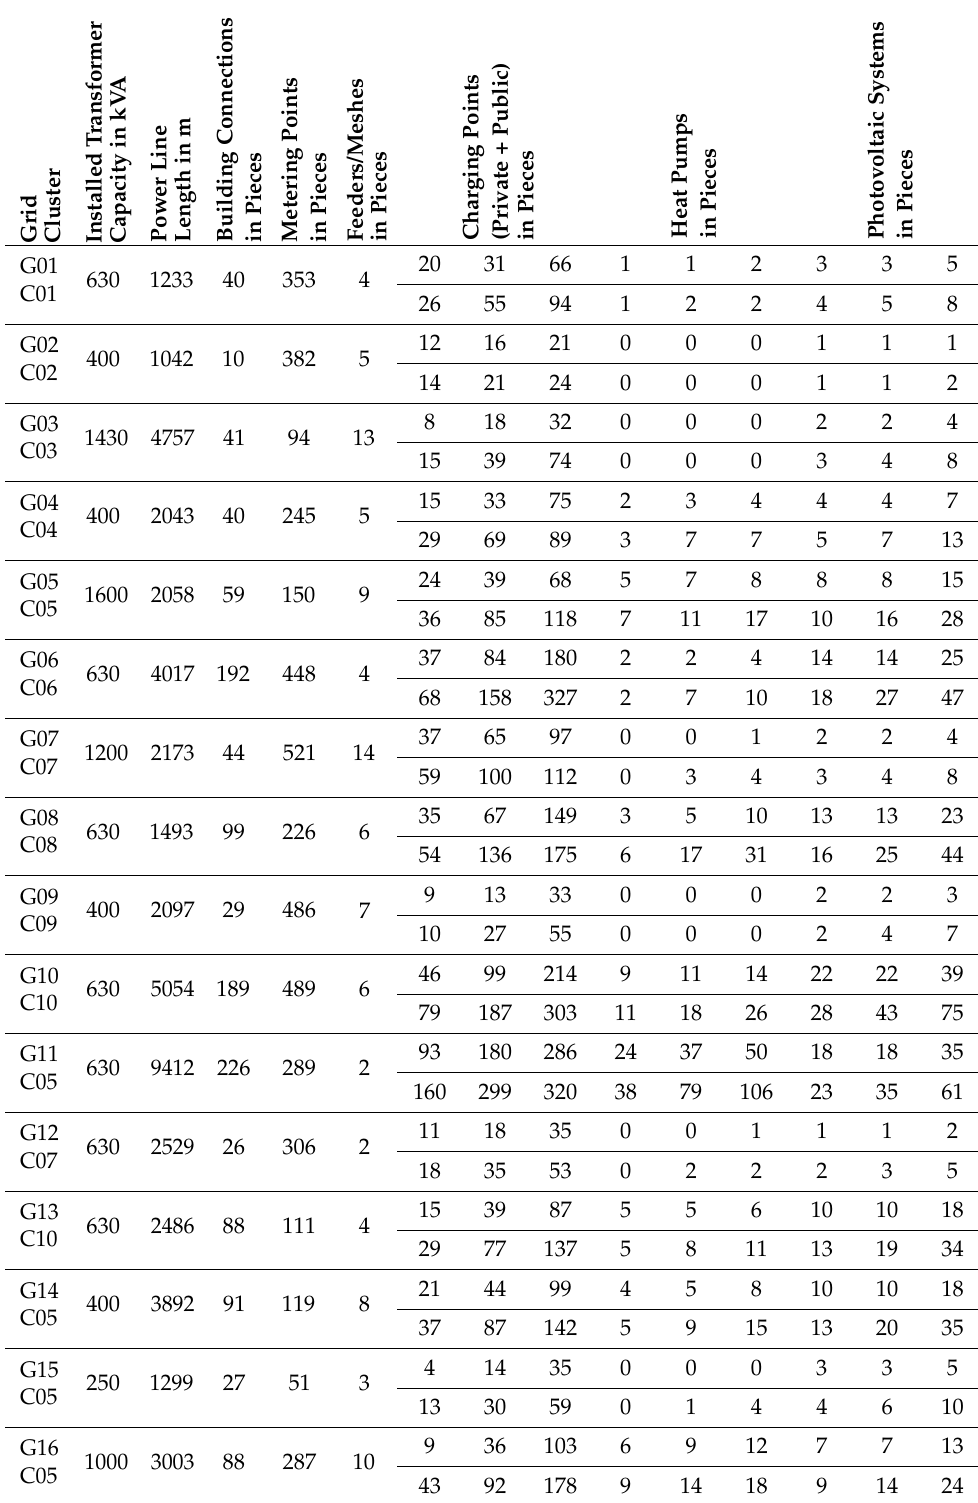
Table A2. Grid structure parameters of the low-voltage grids (values of the scenarios: first line in each case conservative, second line in each case progressive, first column in each case 2030, second column in each case 2040, third column in each case 2050) based on